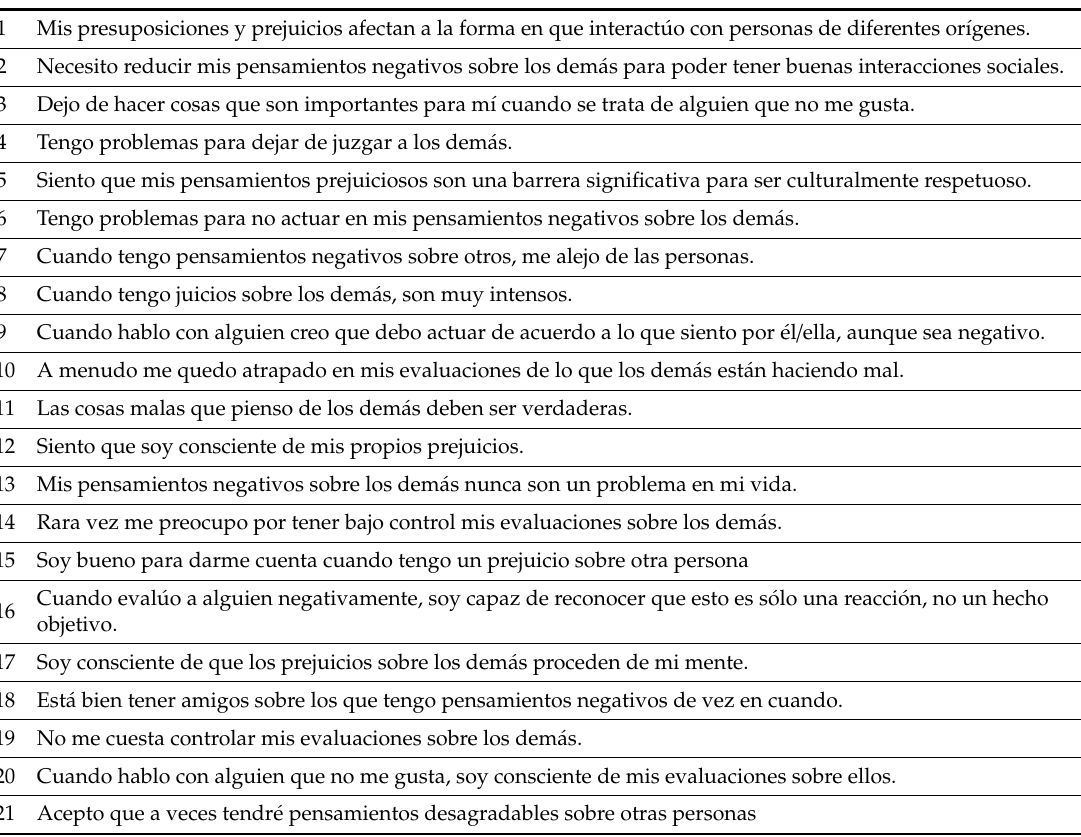
Table A1. This questionnaire was validated in